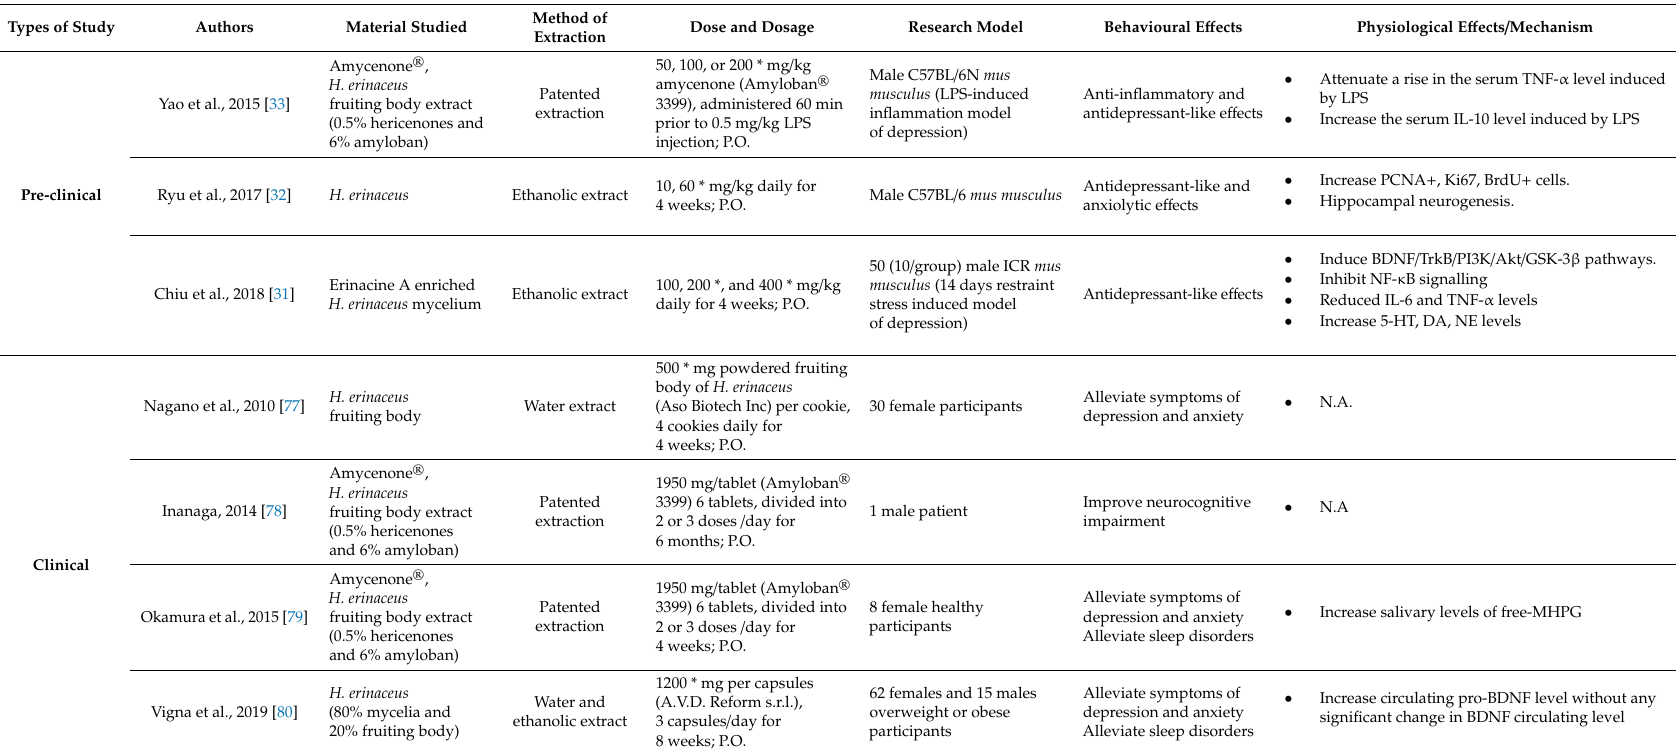
Table 1. The behavioral and physiological e ff ects of di ff erent Hericium erinaceus extracts in the studies of